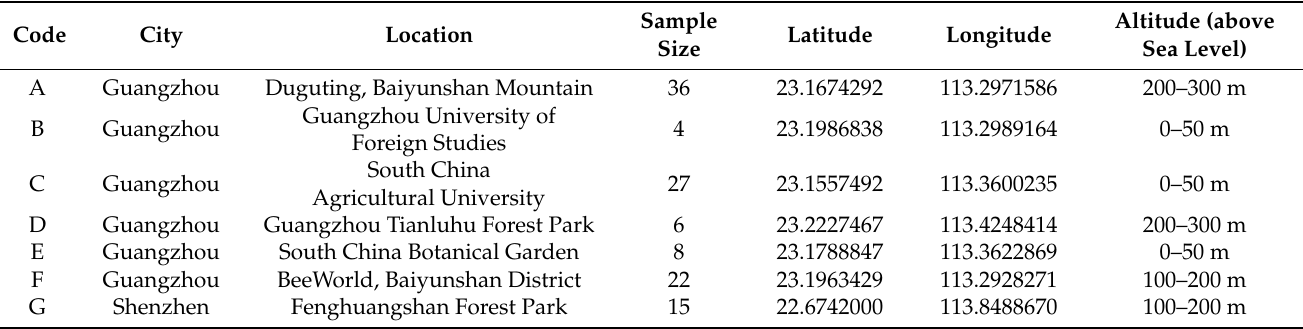
Figure 1. The basidiocarps of A. exitialis. Table 1. Amanita exitialis sample collection